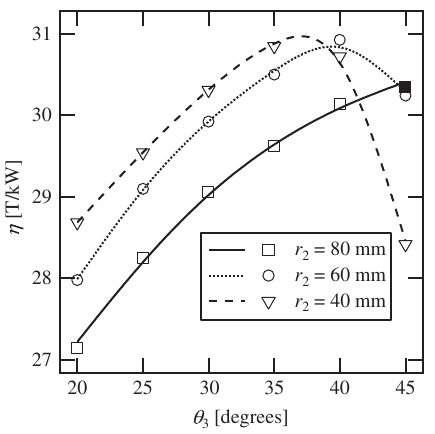
FIG. 6. Magnetic efficiency η vs coil taper angle θ 3 , for different values of the pole taper length r 2 , at θ 2 ¼ 20 °. The black square indicates the design value and the lines are spline interpolations between the simulated points (markers).